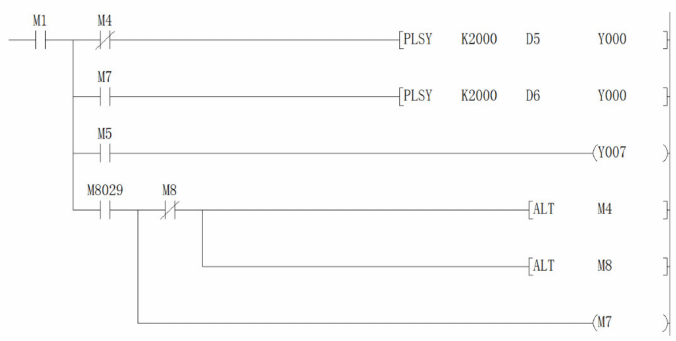
Figure 12. PLC program line diagram of the center distance of the